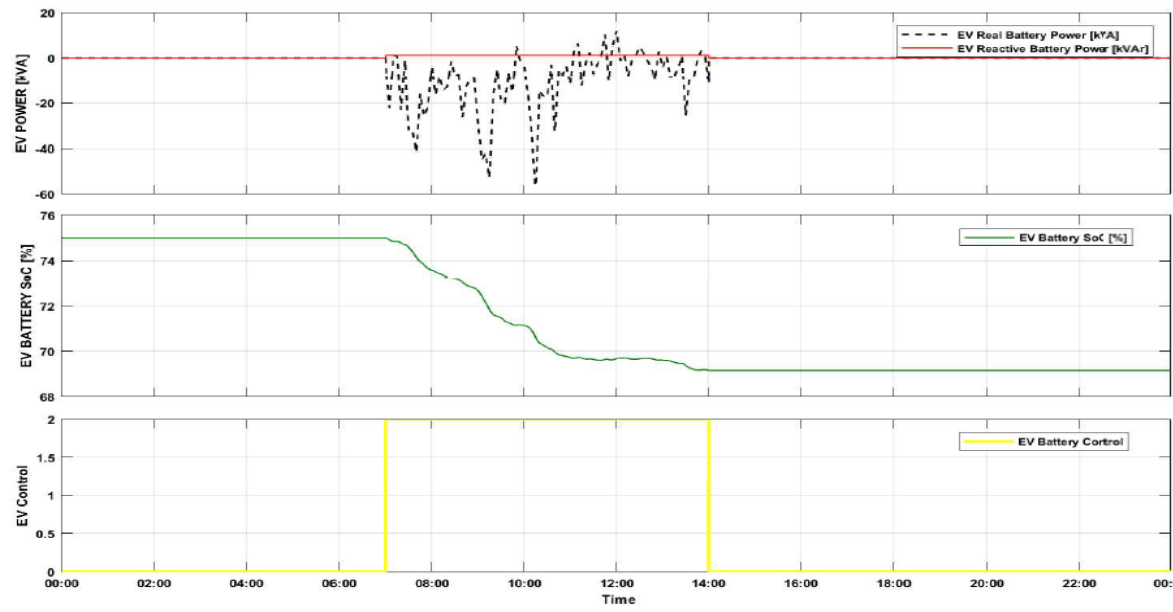
Figure 27. Performance of the EV battery.